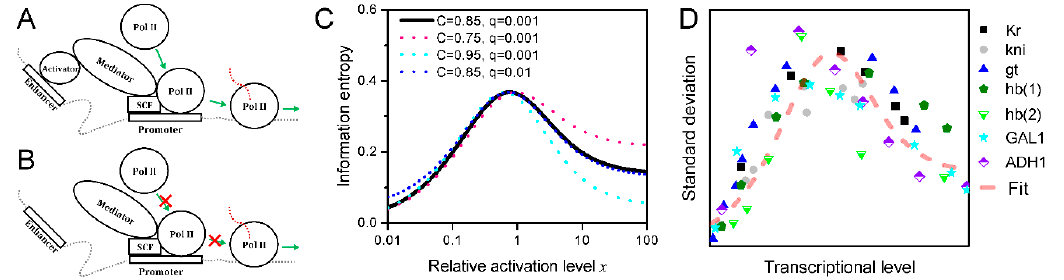
Figure 3. Information entropy of transcriptional regulation based on the architecture of transcription apparatus reproduces transcriptional uncertainty. ( A ) In circumstances where an activator that functions to catalyze transcription initiation is present at the enhancer, successive transcription initiation events lead to a transcriptional burst. ( B ) Else, in the absence of the activator, transcription initiations pause. ( C ) Characteristics of the information entropy as a function of effective activator concentration (i.e., relative activation level). ( D ) Information entropy reproduces the experimental data.